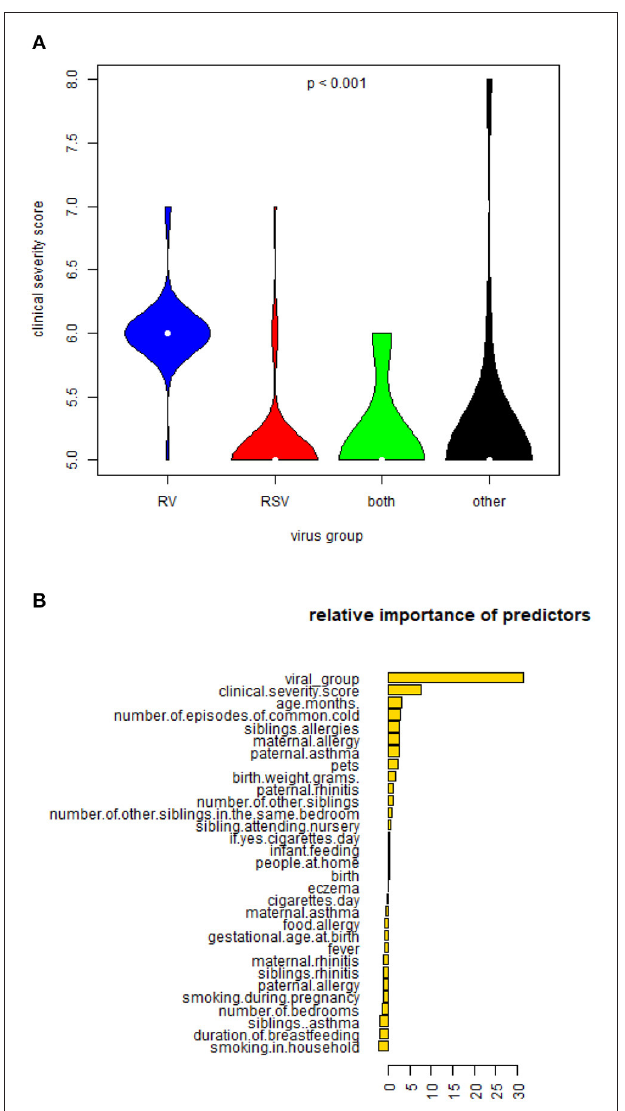
FIGURE 3 | (A) Violin plots depicting differences in mean clinical severity score in infants hospitalized with RV-only, RSV-only, RV and RSV-double positive and other virus-positive bronchiolitis. (B) Figure describing the relative importance of predictors of cluster outcomes.